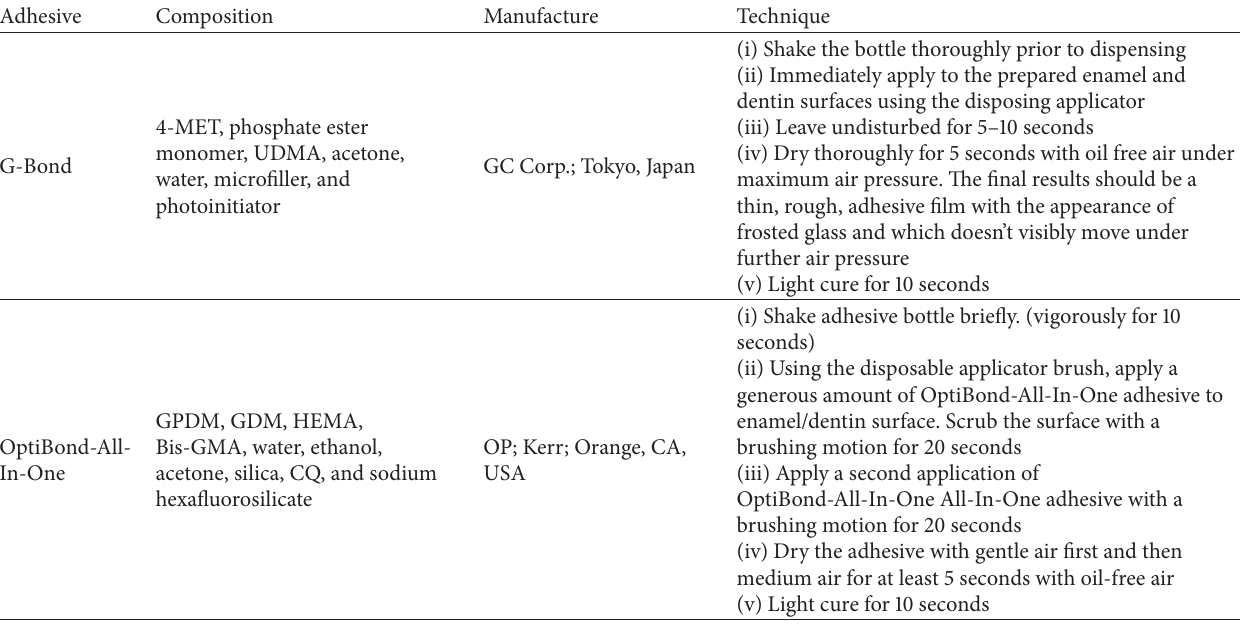
Table 2: Composition and manufacturer’s instructions of adhesive systems used in the